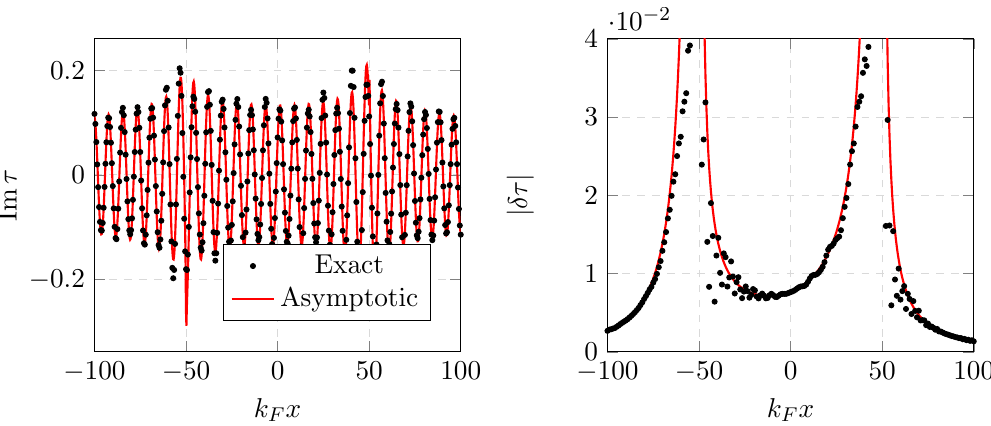
Figure 7: A comparison of the exact expression for the zero temperature τ -function τ ( x ,100 E ) , computed by means of the Fredholm determinant (47) (black dots) F alongside the asymptotics (red solid lines) for ν = 0.4 and k shows the leading asymptotic (95). The right panel compares the exact answer (102) from which the leading asympotics has been subtracted, against the saddle point contributions (101). This singles out the artificial divergence of asymptotic expansion on the light cone. The time is fixed to t = 100 and E = 1 the singularities are located at x = ± 50. Close to the cone, the approximation k F is already